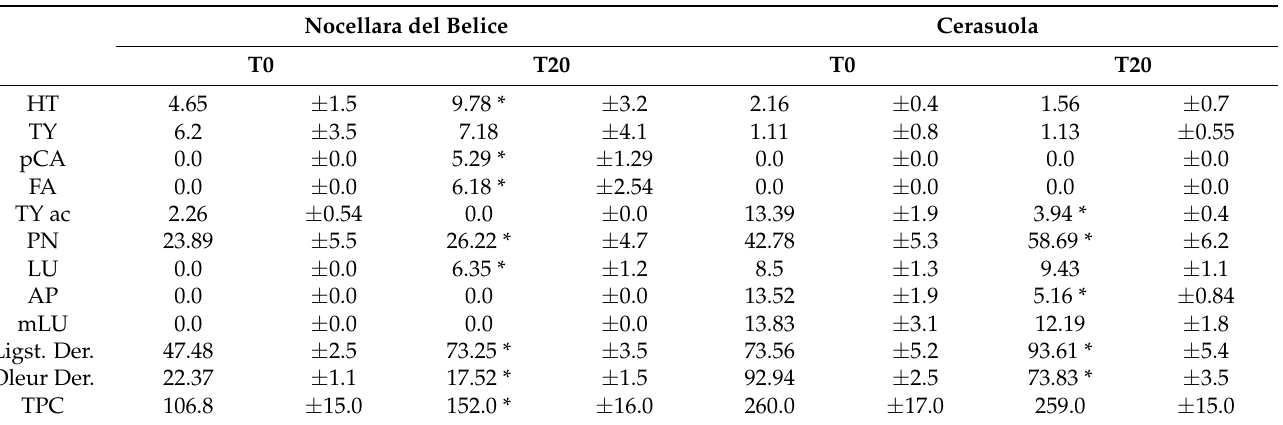
Table 4. Concentration of the biophenols (mean ± SD) of Nocellara del Belice and Cerasuola EVOOs for tests T0 (unmodified malaxation) and T20 (modified malaxation, with the application of the SCADA platform). Data are expressed in ppm.